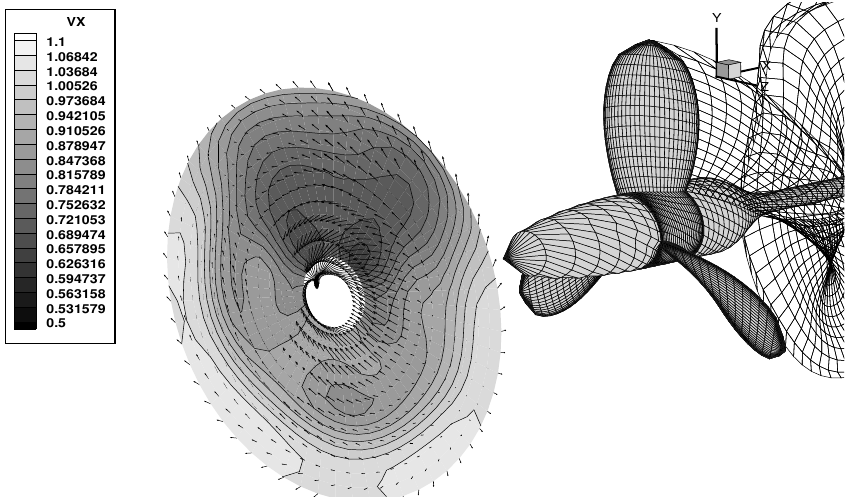
Figure 16. Geometry of DTMB N4148 propeller subject to the non-axisymmetric effective wake. Only the key wake is shown, and the wake disk is shifted upstream for clarity.